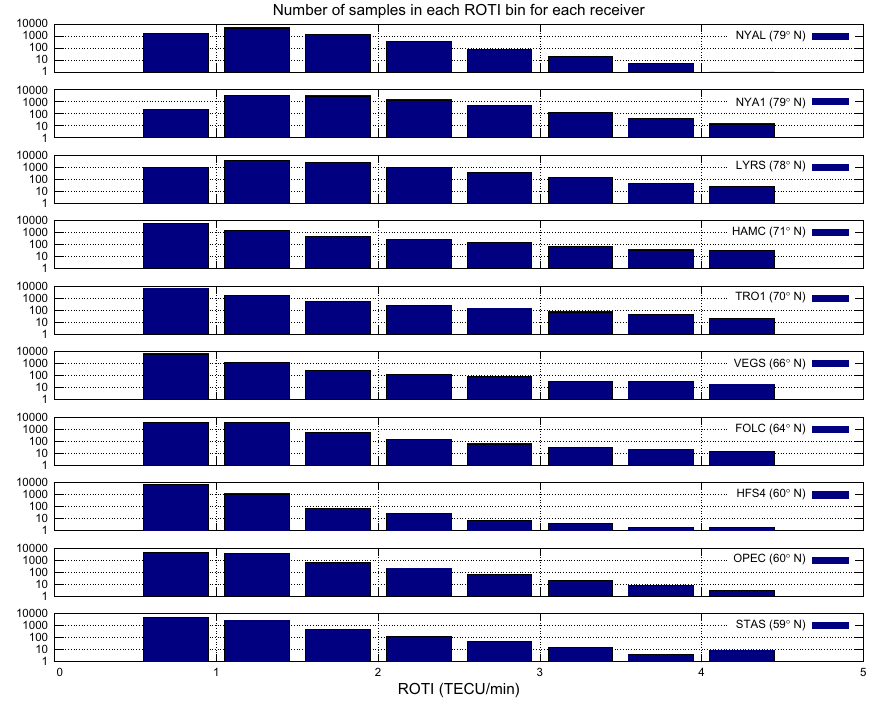
Fig. 5. Number of samples in the bins for Figures 3 and 4.